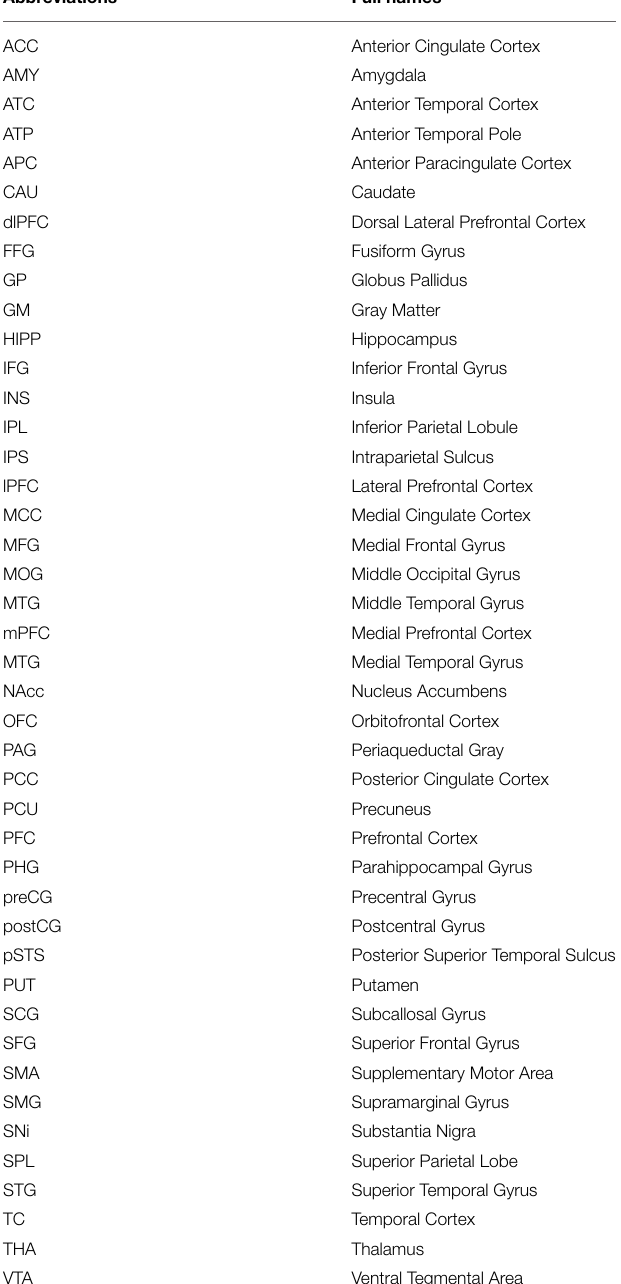
TABLE 2 | The abbreviations and full names of activated brain